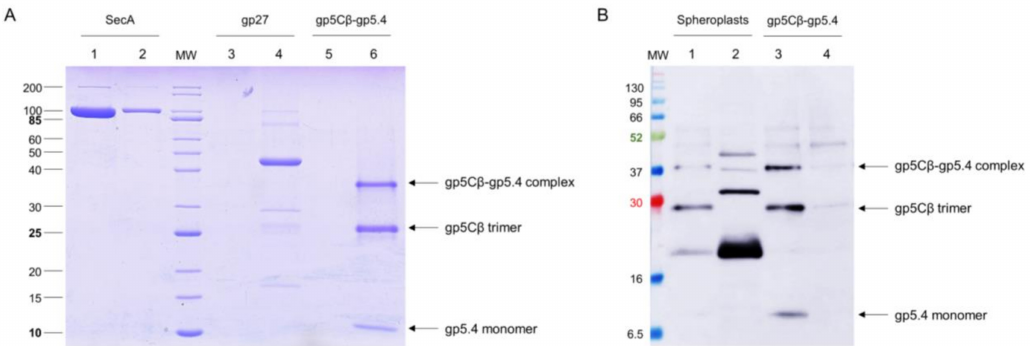
Figure 4. ( A ) The gp5C β –gp5.4 complex does not bind to liposomes. The purified complex